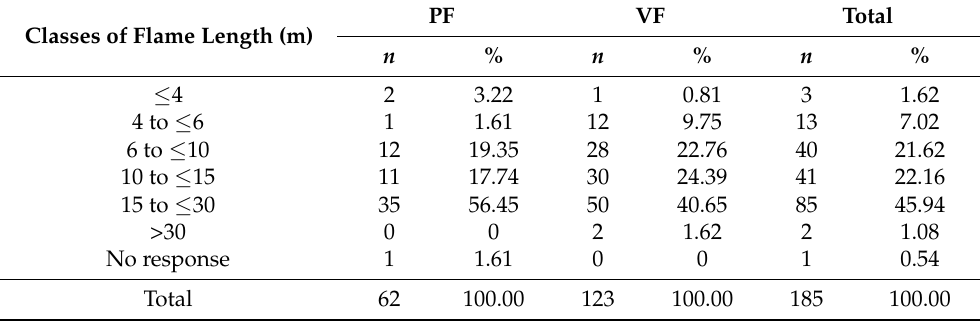
Table 3. Flame length/height.